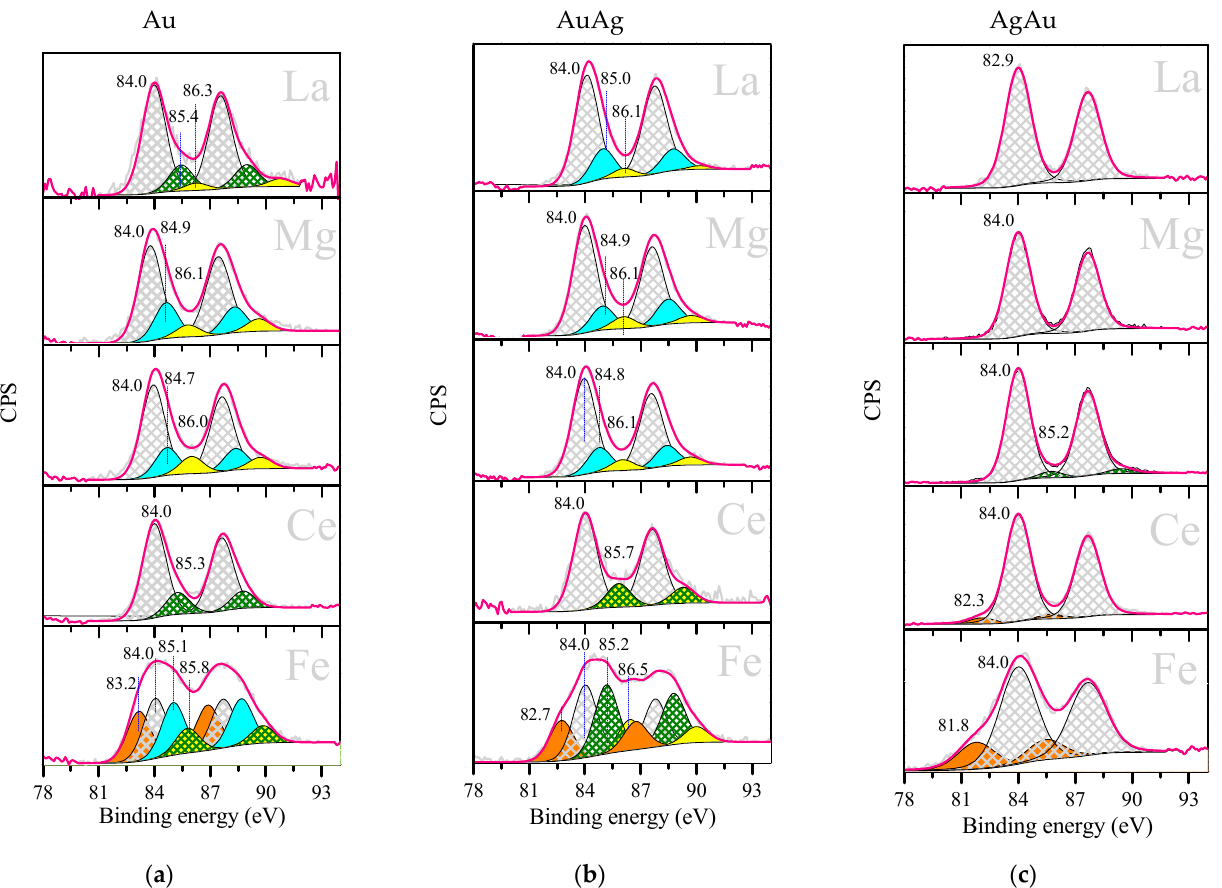
Figure 4. Au 4f 7/2 XPS for Au ( a ), AuAg ( b ), AgAu ( c ) catalysts supported on M/TiO 2 , where M is La, Mg, Ce or Fe. Samples were studied after reduction in H 2 at 300 °C for 1 h. Previously reported XPS data for Au/M/TiO 2 catalysts are included for comparison, reprinted from [39,40] (copyright 2004), with permission from Elsevier. Table 1. Binding energies (BE) of different gold electronic states (eV) and their relative content (%), indicated in parentheses. Data for Au/M/TiO 2 catalysts are reprinted from [39,40] (copyright 2004), with permission from Elsevier. Catalysts